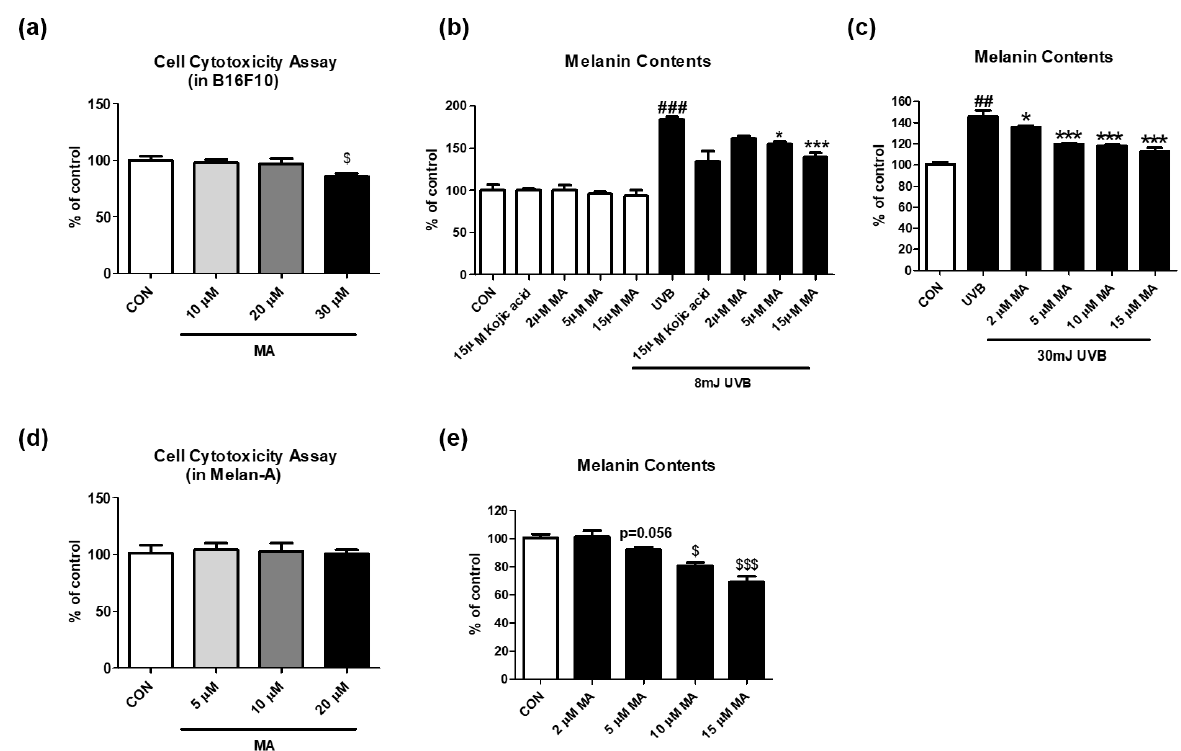
Figure 2. Effect of maclurin on melanogenesis in B16F10 cells. ( a ) Cell cytotoxicity was measured in B16F10. The cells were treated with various concentrations (10, 20, and 30 μM) of maclurin for 24 h. The cell viability was evaluated by treatment of cell toxicity solution based on materials and methods. The effects of maclurin on spontaneous melanogenesis were investigated using B16F10 cells without any extrinsic stimulations. To test the melanin inhibitory effect of maclurin against UVB exposure, the cell was pretreated with maclurin for 1 hr and then exposed to ( b ) 8 mJ or ( c ) 30 mJ of UVB radiation followed by incubation for 3 days. To investigate the anti-melanogenic effects of maclurin in normal melanocytes, melan-a cells were cultured using a method indicated in the Section 2, ( d ) cell cytotoxicity and ( e ) melanin contents were measured. All data represented the mean ± SEM at least three times. $ p < 0.05 and $$$ p < 0.001 compared to the control group. ## p < 0.01, ### p < 0.001 compared with the non-exposed control group and * p < 0.05 and *** p < 0.001 compared to the UVB-exposed